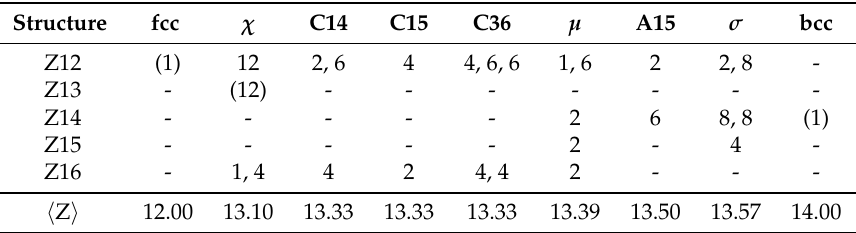
Table 1. Frank–Kasper polyhedra with coordination numbers Z of the considered TCP phases, ordered by increasing average Z. The list indicates the multiplicity of the different Wyckoff positions with the same Z . The values in parentheses indicate coordination polyhedra that are not Frank–Kasper